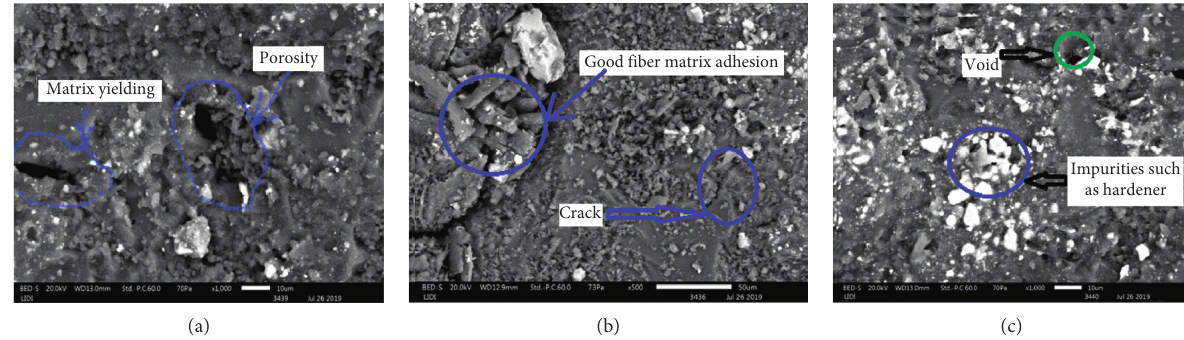
Figure 13: (a) 40% by weight 45 ° / − 45 ° WSFRUPC 10 μ m SEM micrograph. (b) 40% by weight 45 ° / − 45 ° WSFRUPC 10 μ m SEM